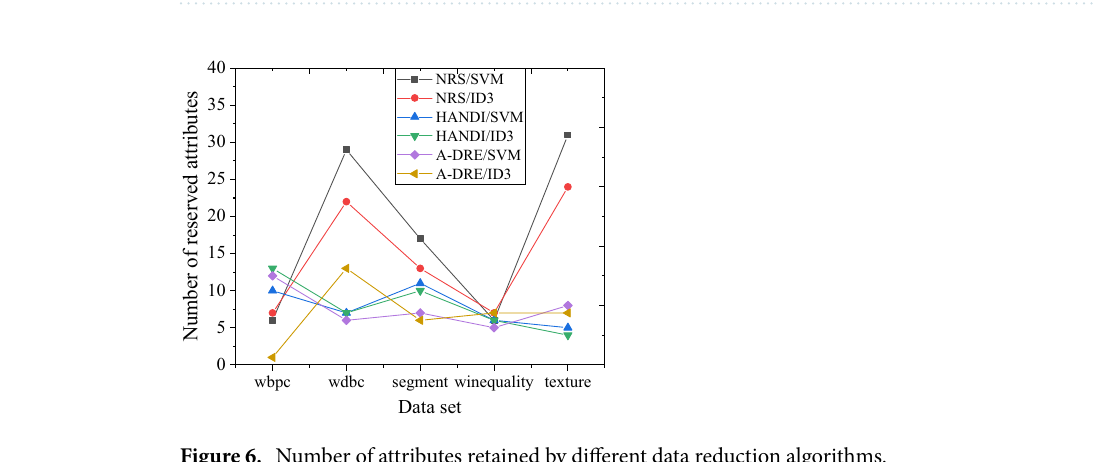
Figure 6. Number of attributes retained by different data reduction